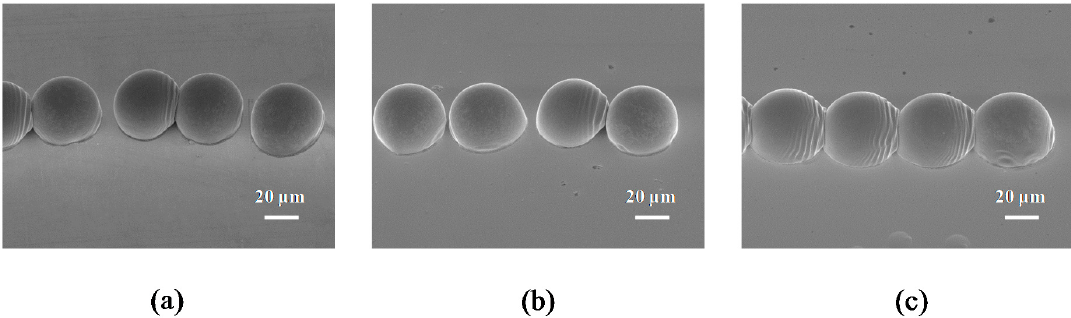
Figure 6. The deposition of a molten metal droplet under different stage velocities with the following initial characteristics: diameter D 0 = 50 μ m, velocity = 1.1 m ∙ s − 1 , dot spacing = 50 μ m, and sample temperature 30 °C (Stefan number Ste = 0.722). ( a ) 5 mm ∙ s − 1 (frequency = 100 Hz); ( b ) 10 mm ∙ s − 1 (frequency = 200 Hz); ( c ) 50 mm ∙ s − 1 (frequency = 1000 Hz). The scale bars are 20 μ m.